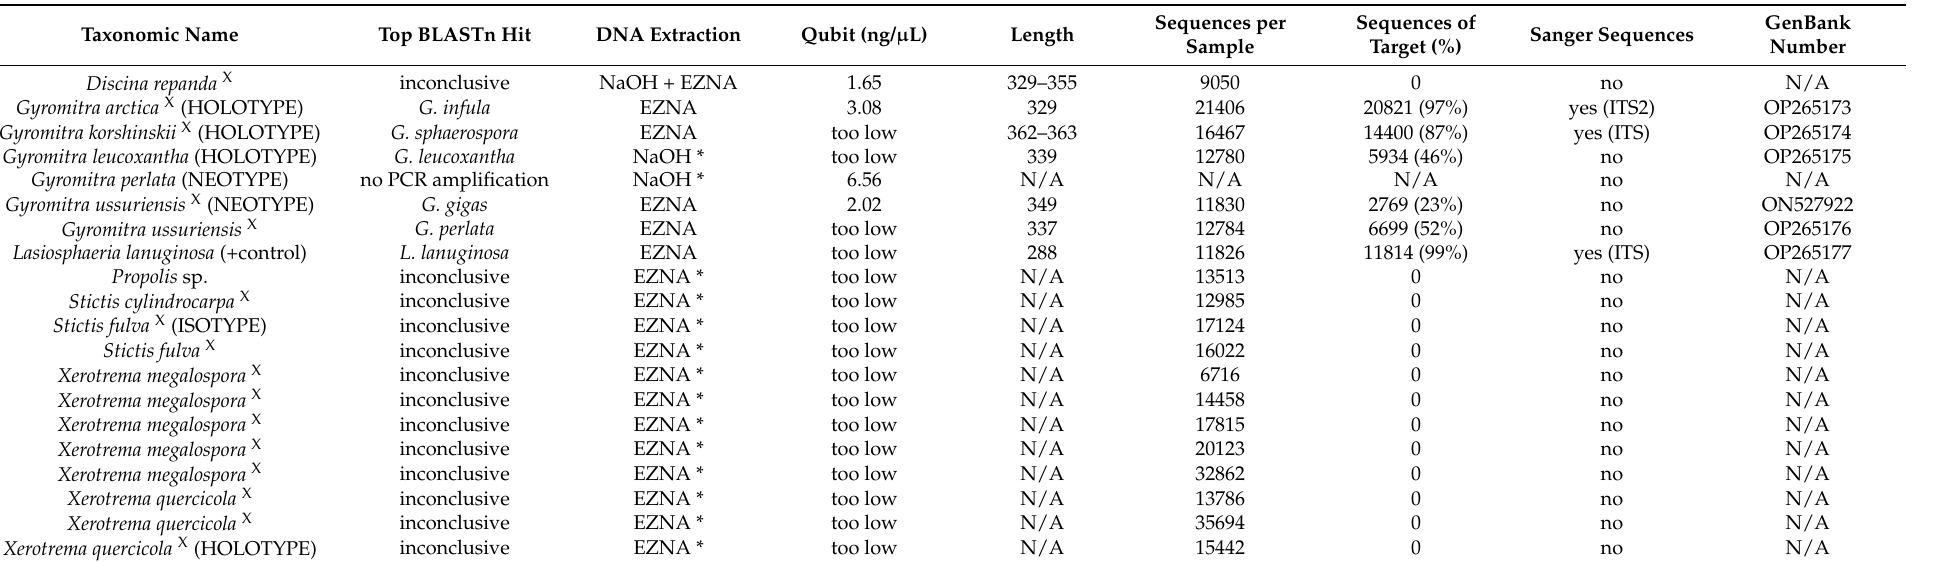
Table 2. Results of Illumina sequencing showing the taxonomic name assigned to the sample, the top BLASTn hit, type of DNA extraction, Qbit score, length of ITS2 sequences, number of sequences generated per samples, number and percent of sequences matching the target species, whether Sanger sequences of the entire ITS or ITS2 were generated, and GenBank accession